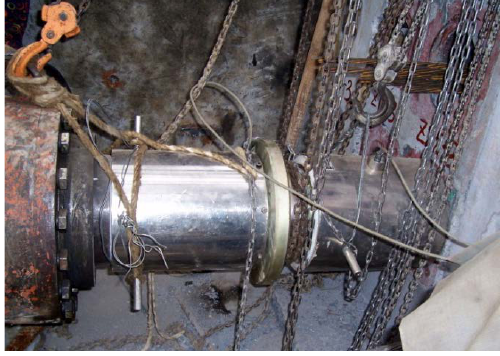
Figure 10. Loading device.